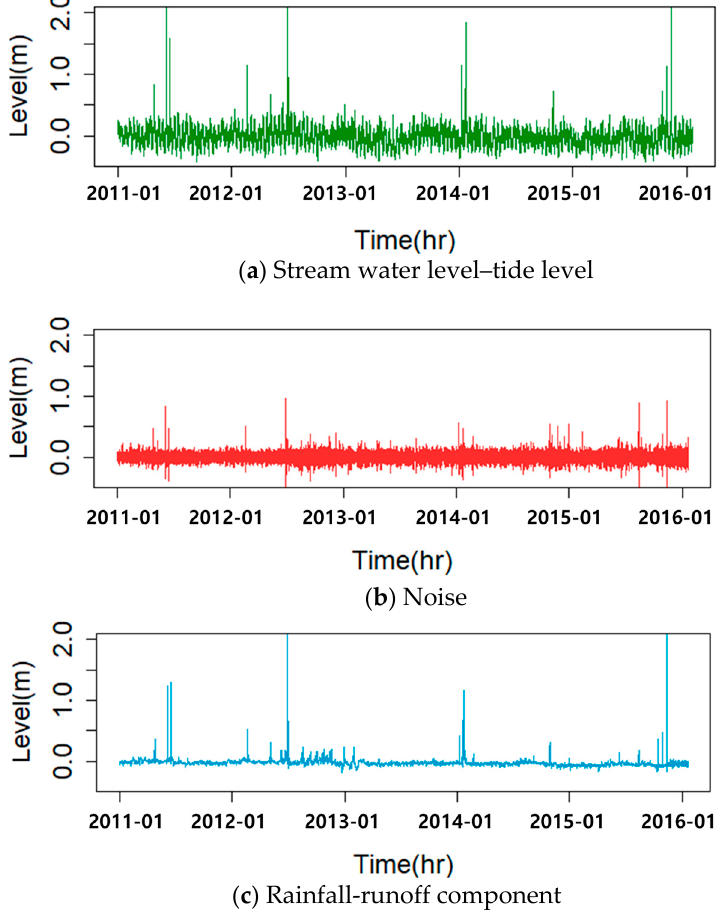
Figure 8. Noise and rainfall-runoff components. High pass filter was applied because the noise component has a high frequency characteristic as shown in Figure 2. Finally, Rainfall-runoff component could be separated by subtracting the value from ( a ) Stream water level–tide level to ( b ) Noise.